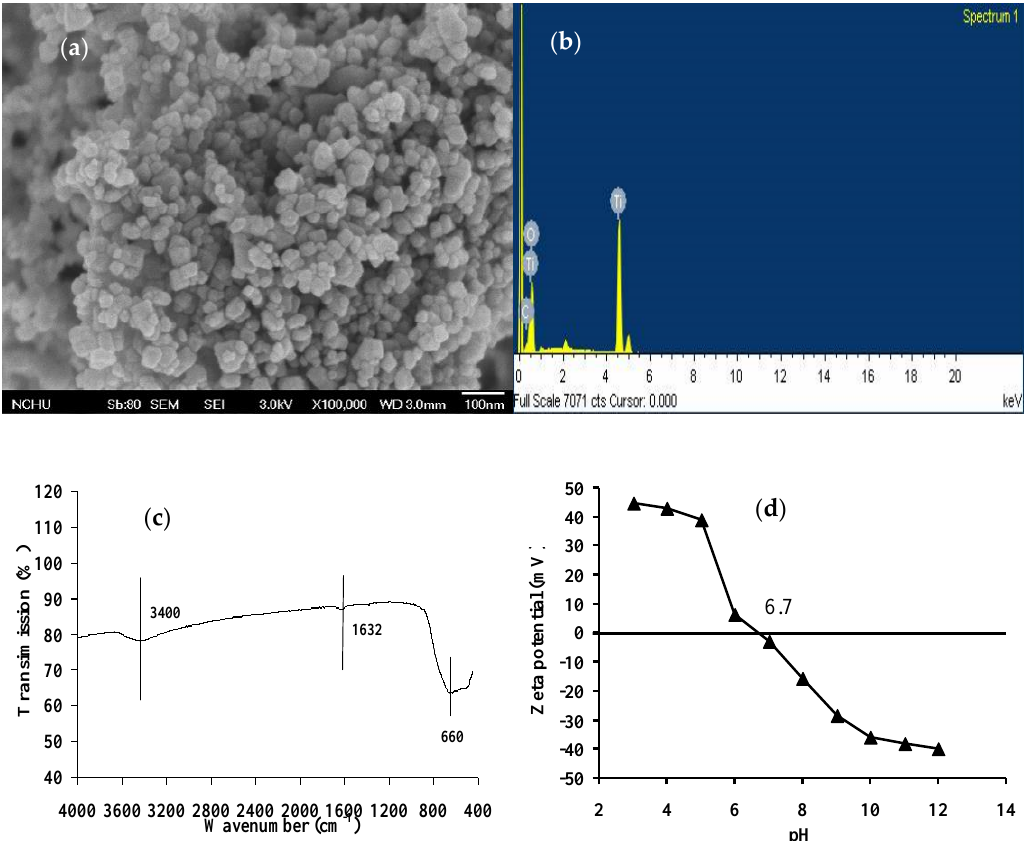
Figure 1. ( a ) FE-SEM image; ( b ) EDS spectra; ( c ) FTIR spectra; ( d ) zeta potential of commercial TiO2 of Degussa P25 used in the study.